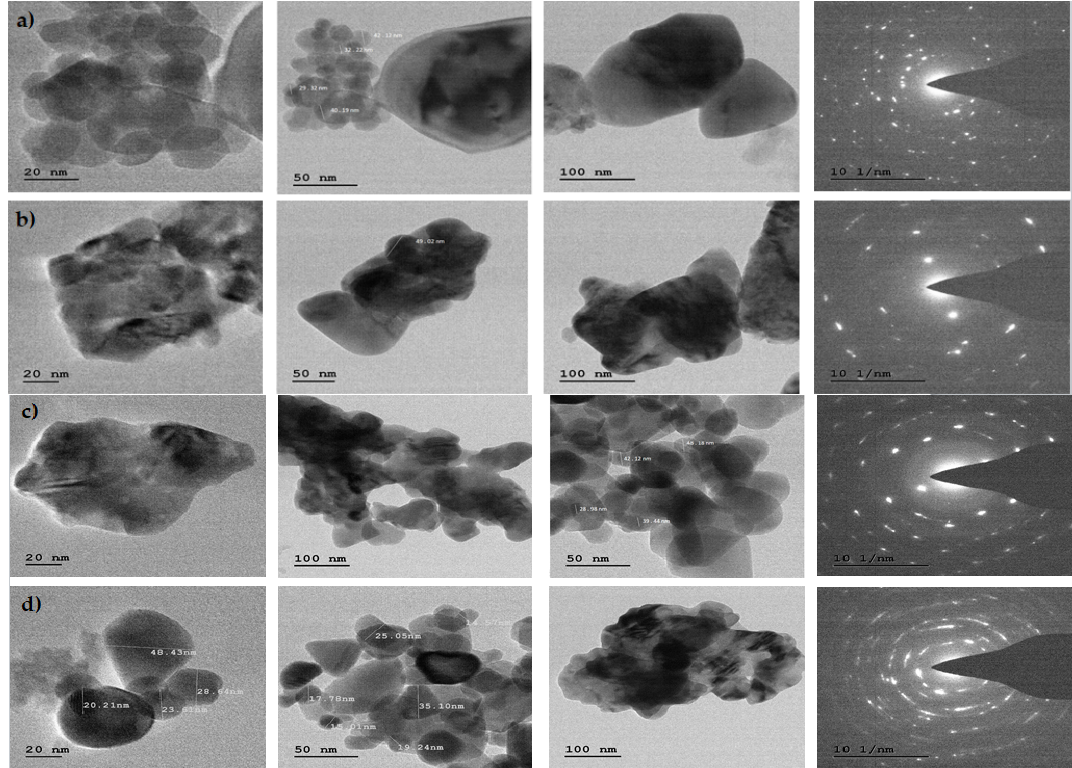
Figure 9. TEM micrographs (at different magnifications) and SAED patterns of Zno NPs synthesized from ( a ) Trichoderma harzianum (PGT4); ( b ) Trichoderma reesei (PGT5); ( c ) Trichoderma reesei (PGT13); and ( d ) Trichoderma spp. co-culture (PGTA).